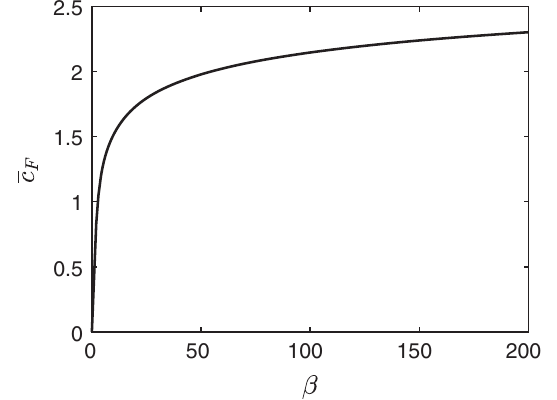
FIG. 12. Spreading velocity of the linearized model for K ¼ 1 . 0 as a function of the burst size β (in the linearized model, K and β are the only independent